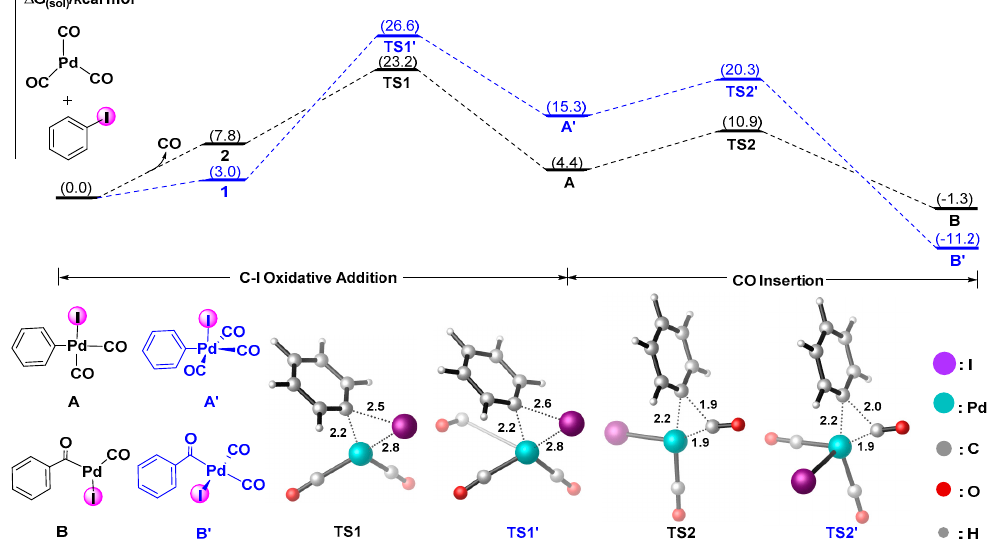
Figure 1. Computed reaction potential surfaces of formation of palladium-aroyl intermediate (associative mechanism in blue vs. dissociative mechanism in black).